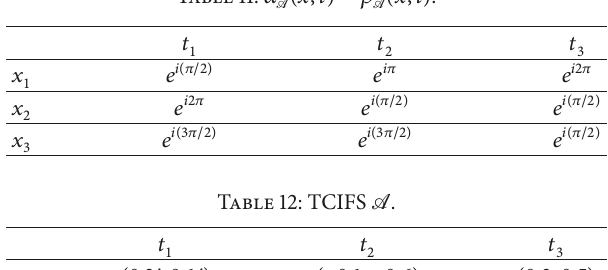
Table 11: 𝛼 A (𝑥,𝑡) = 𝛽 A (𝑥,𝑡) .